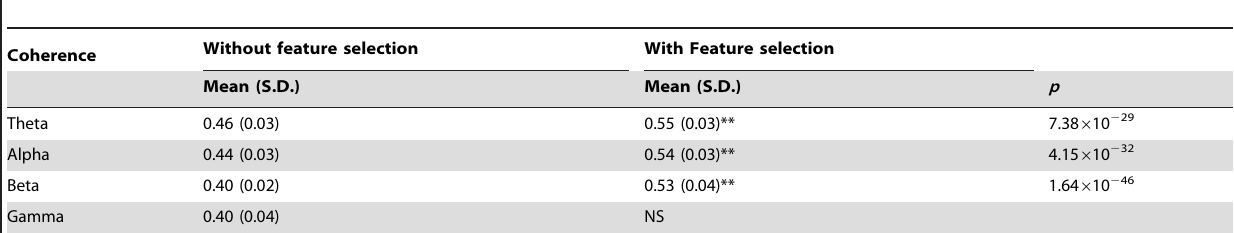
Table 5. Comparison of Classification Accuracy in Different Frequency Bands With and Without Feature Selection Base on